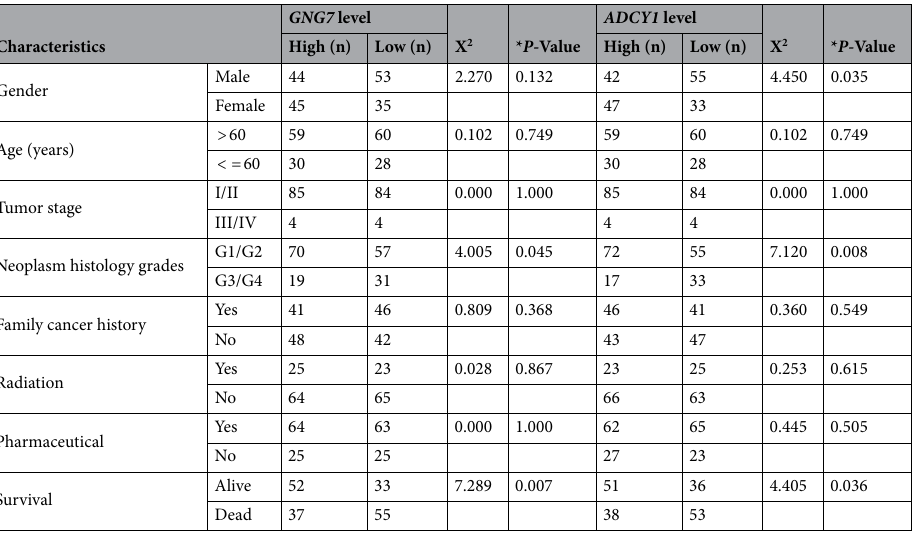
Table 2. Correlation between GNG7, ADCY1 expression and clinical outcomes in PAAD (177cases, GDC TCGA pancreatic Cancer cohort).